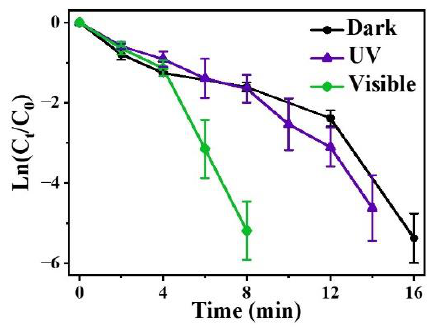
Figure 3. Plots of Ln(C t /C 0 ) versus the reaction time for the reduction of 4-NP over Ag/p-ZnO in the dark, and under UV and visible light irradiation. the dark, and under UV and visible light